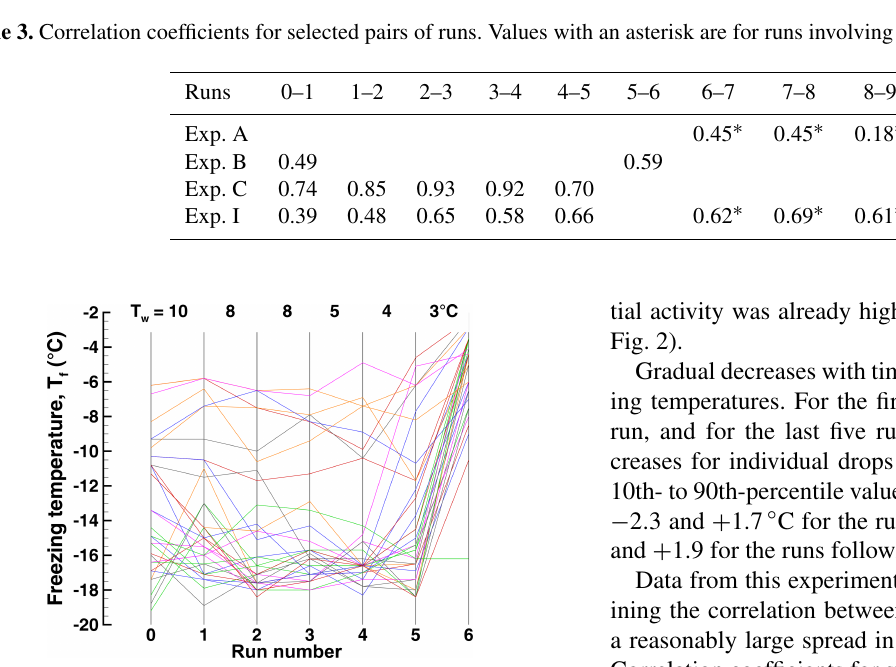
Figure 12. Spiderweb diagram of individual drop histories for the sequence of runs with decreasing warm limits in Exp. C. A statisti- cal representation of these observations is given in Fig. 5.